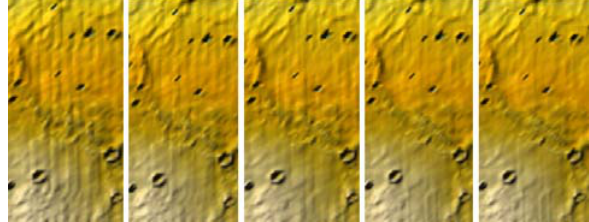
Figure 5. The DEMs before and after adjustment in a local area